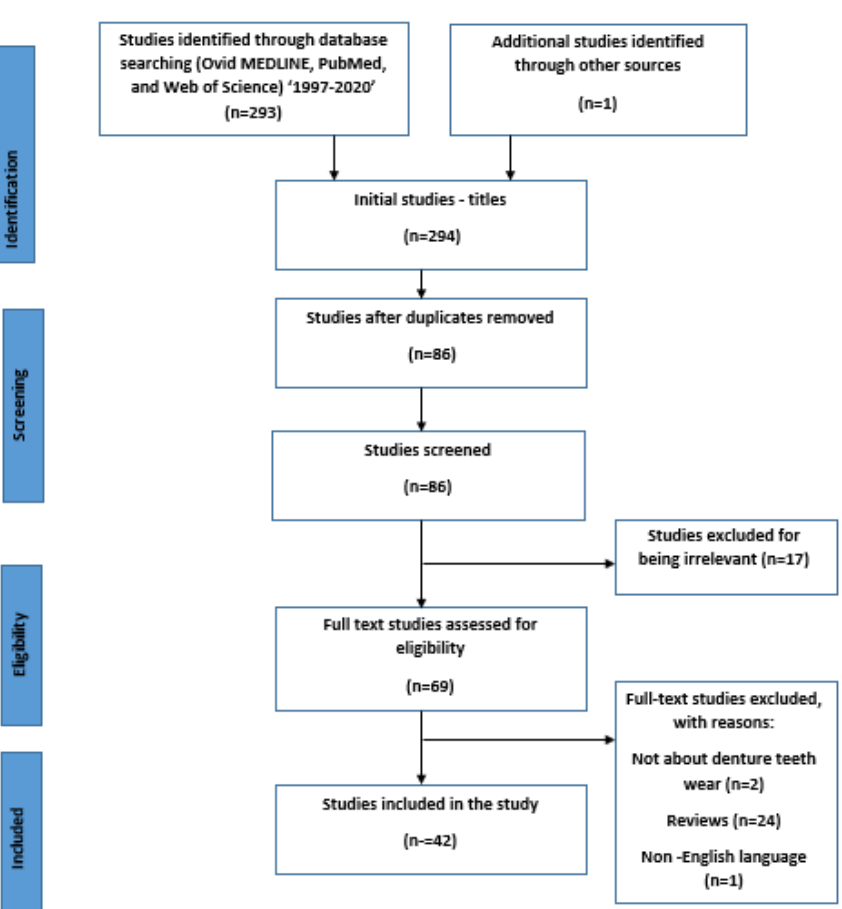
Figure 1. PRISMA flow diagram of literature search and selection process.